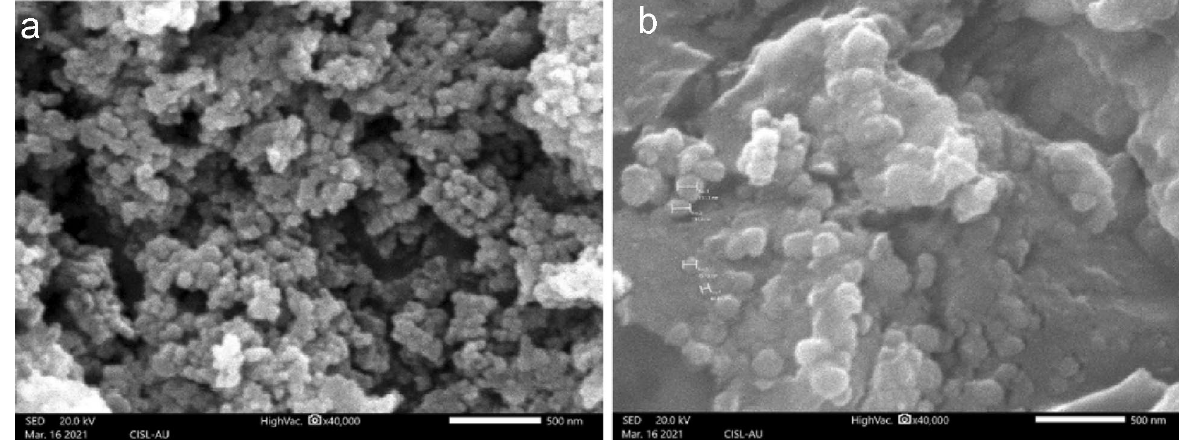
Figure 3. SEM analysis of ( a ) SPIONs; ( b ) Latex coated SPIONs.